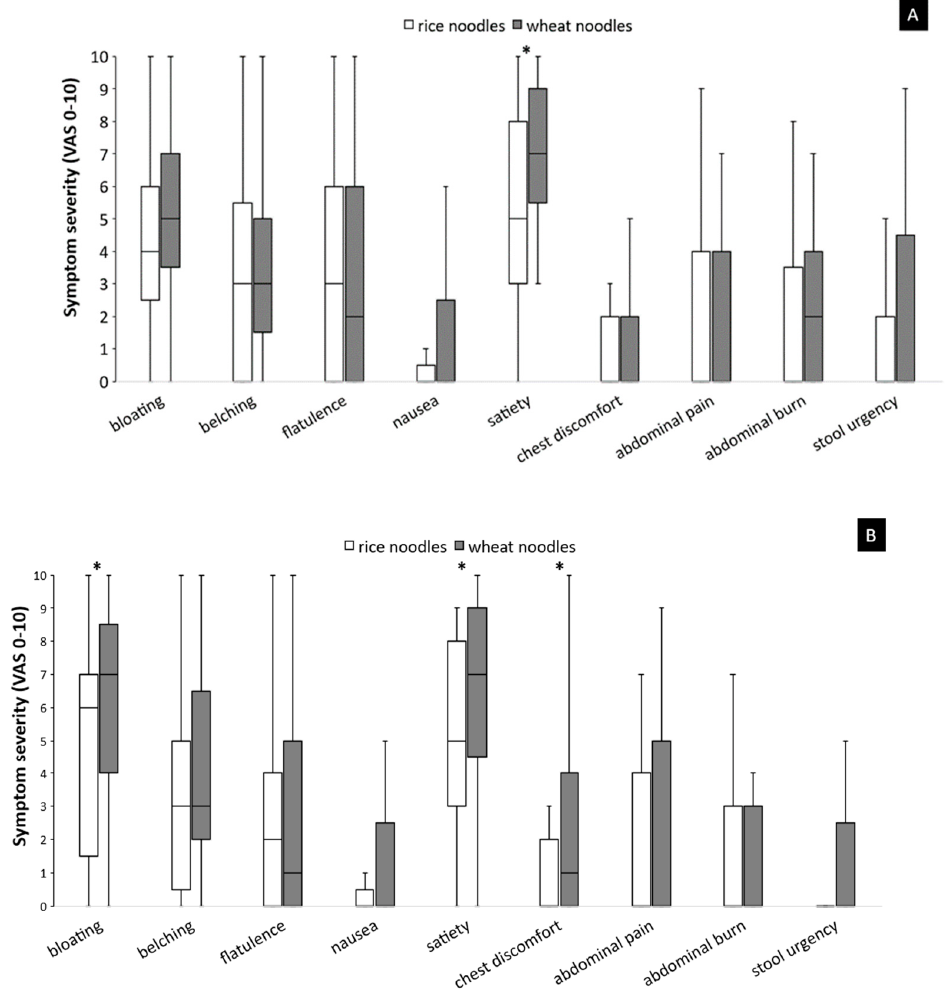
Figure 2. The maximal gastrointestinal symptom scores during 4 h after breakfast ( A ) and lunch ( B ), comparing between wheat and rice noodles ingestion. Symptoms were evaluated by visual analog scale (VAS) 0–10. A box and whisker plot represents the median, interquartile range, minimal, and maximal values of symptom severity. * p < 0.05 wheat noodles vs. rice noodles.